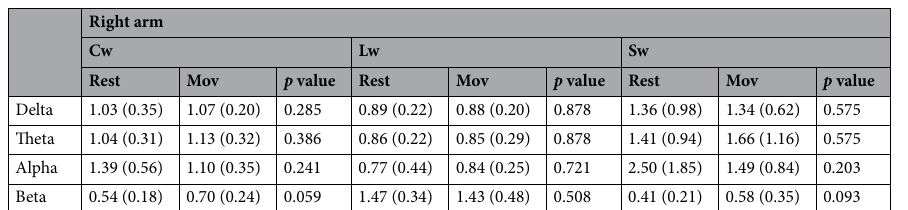
Table 1. Wilcoxon test for Cw, Lw and Sw between the two different experimental conditions (Rest and Mov) for each EEG frequency band during the trials performed with the right arm.